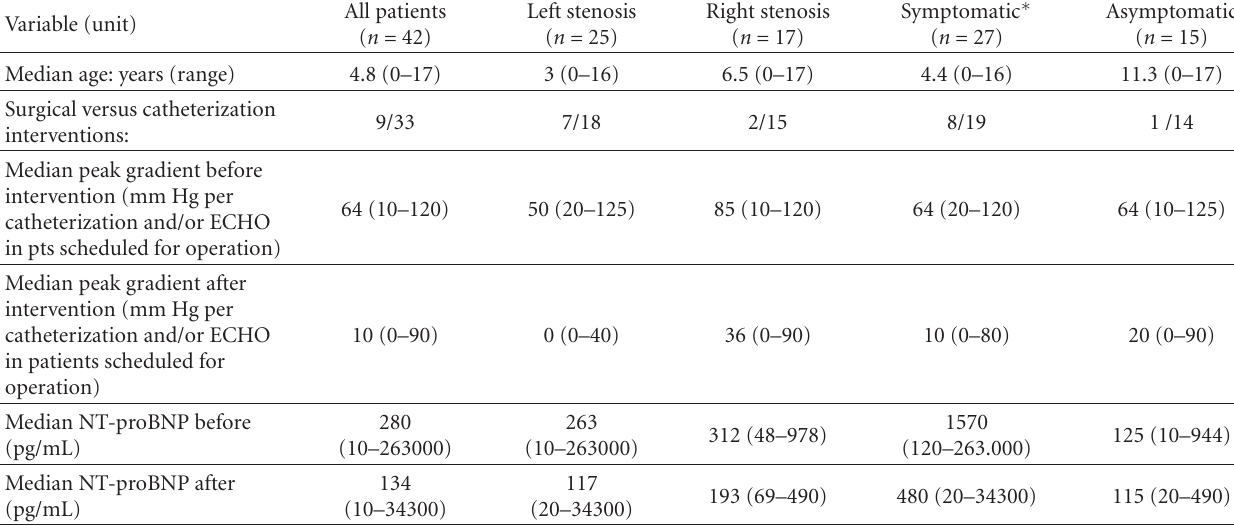
Table 2: Patient characteristics, clinical and echocardiographic data in median with range.